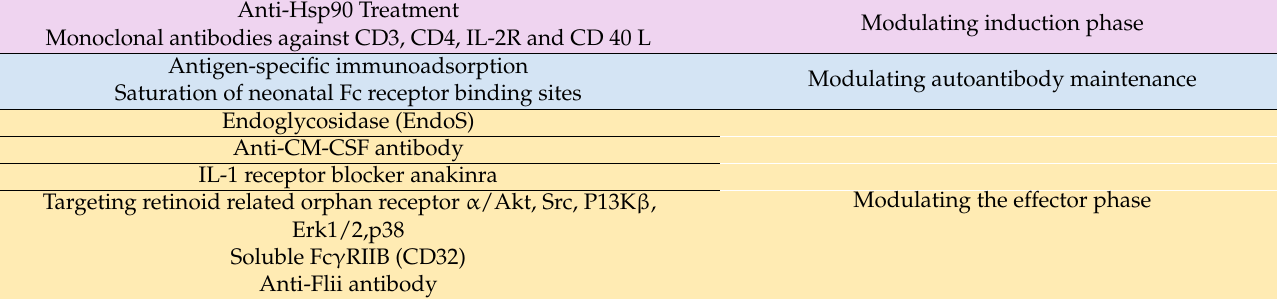
Table 2. Novel therapeutic